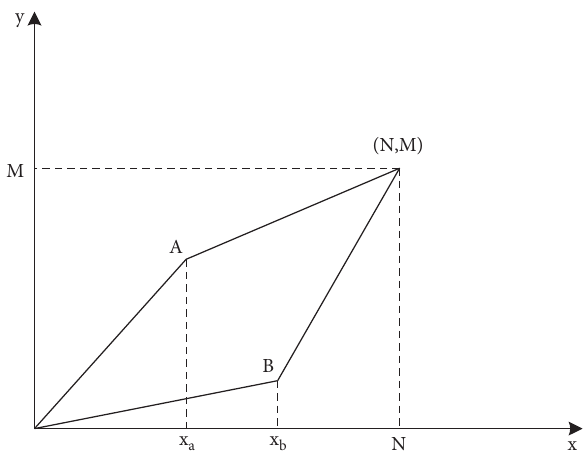
Figure 3: Schematic diagram of algorithm path constraint.